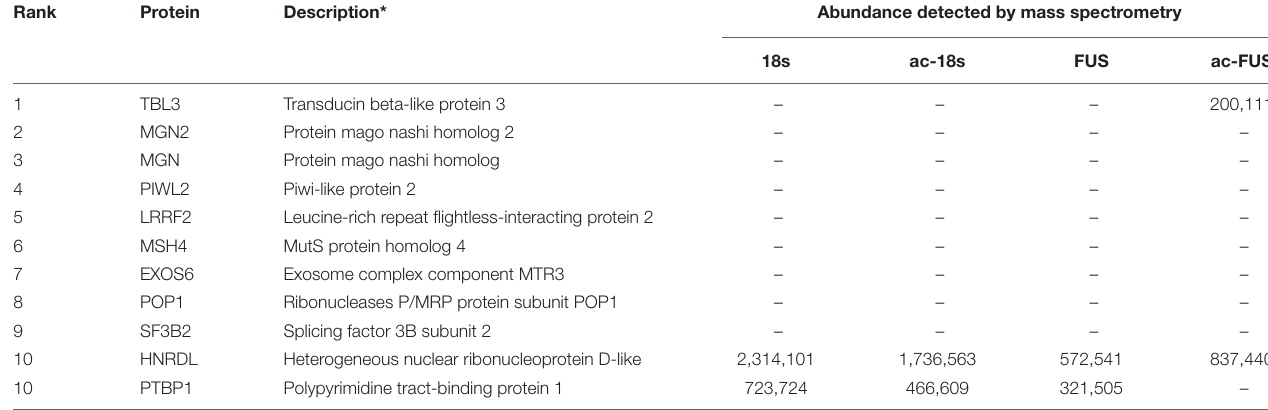
TABLE 3 | Top 10 RNA-binding proteins predicted by catRAPID and their abundance in mass